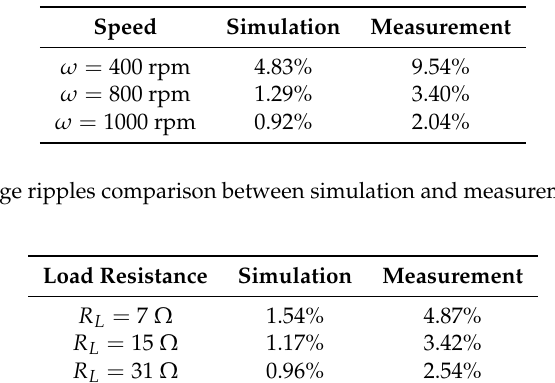
Table 3. DC bus voltage ripple comparison between simulation and measurement at V DC = 24 V and R L = 15 Ω .